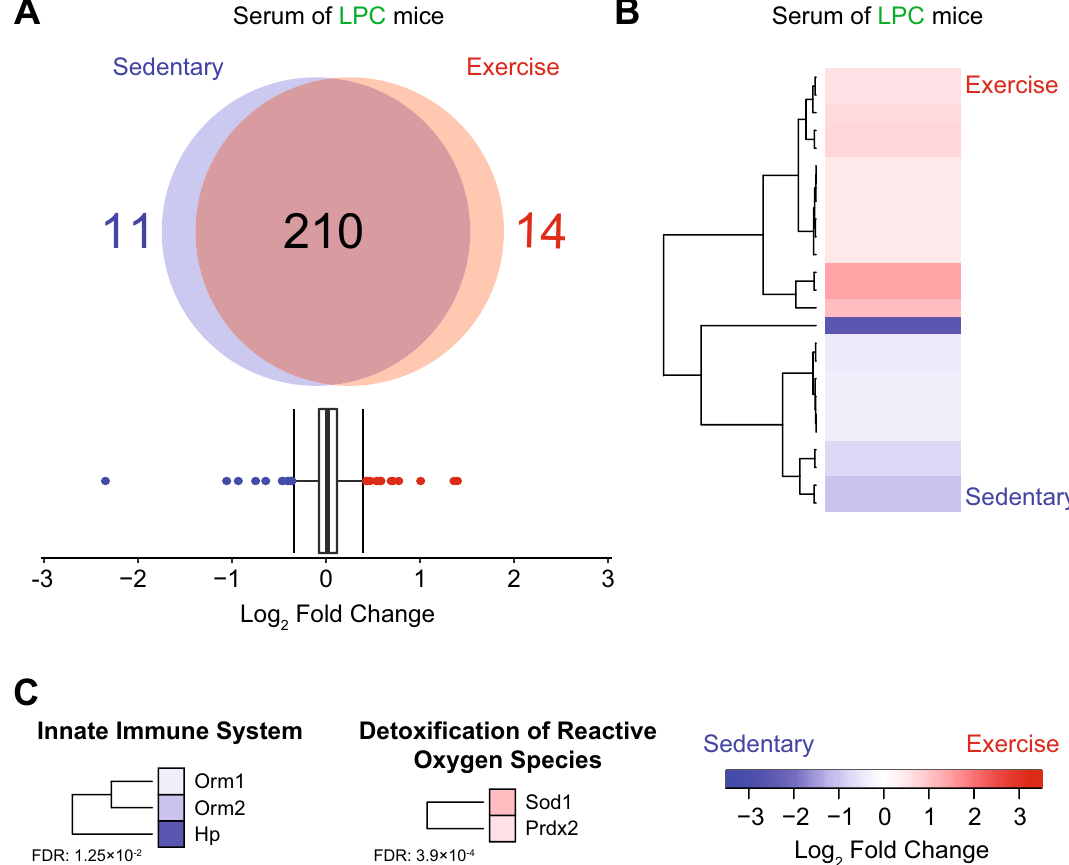
Figure 5. Effect of exercise on LPC demyelinated serum proteome after 4 days of running wheel. ( A ) Quantification of differentially expressed proteins in LPC demyelinated serum 4 dpi as determined by interquartile box plot analysis. A false discovery rate (FDR) of 1% was applied to the database search on MaxQuant. ( B ) Heatmap of differentially expressed proteins in LPC demyelinated serum. ( C ) Heatmap of proteins and associated reactome pathways as determined by STRING (https:// string- db. org). A false discovery rate (FDR) for each pathway was added on the left of each heatmap. Interquartile box plot analysis was used for statistics. Data analysis was accomplished using the R software 32 . The plot was generated using the heatmap.2 function from the gplots package 34